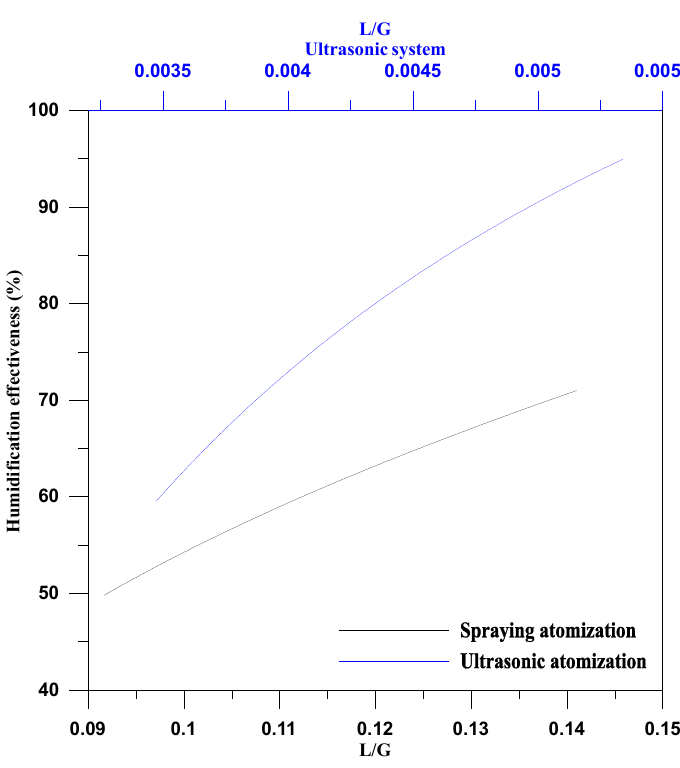
Figure 8. Effectiveness of humidification process for spraying and ultrasonic water atomizers.